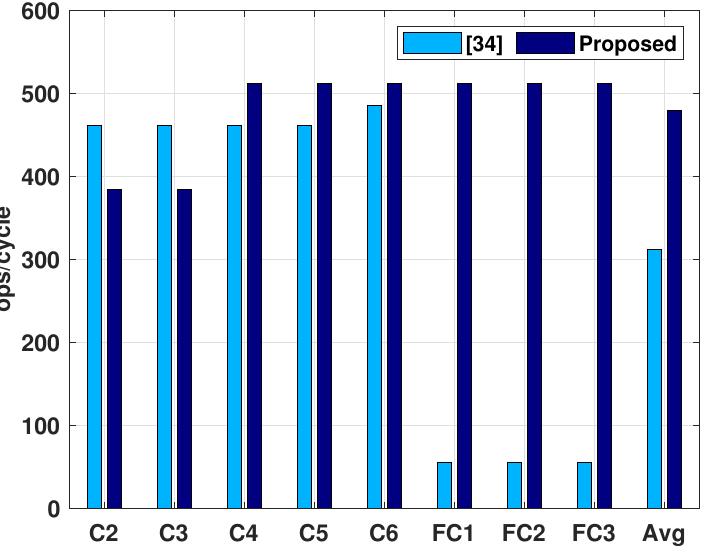
Figure 7. Comparison results of throughput performance for BNN-Cifar10. ops,